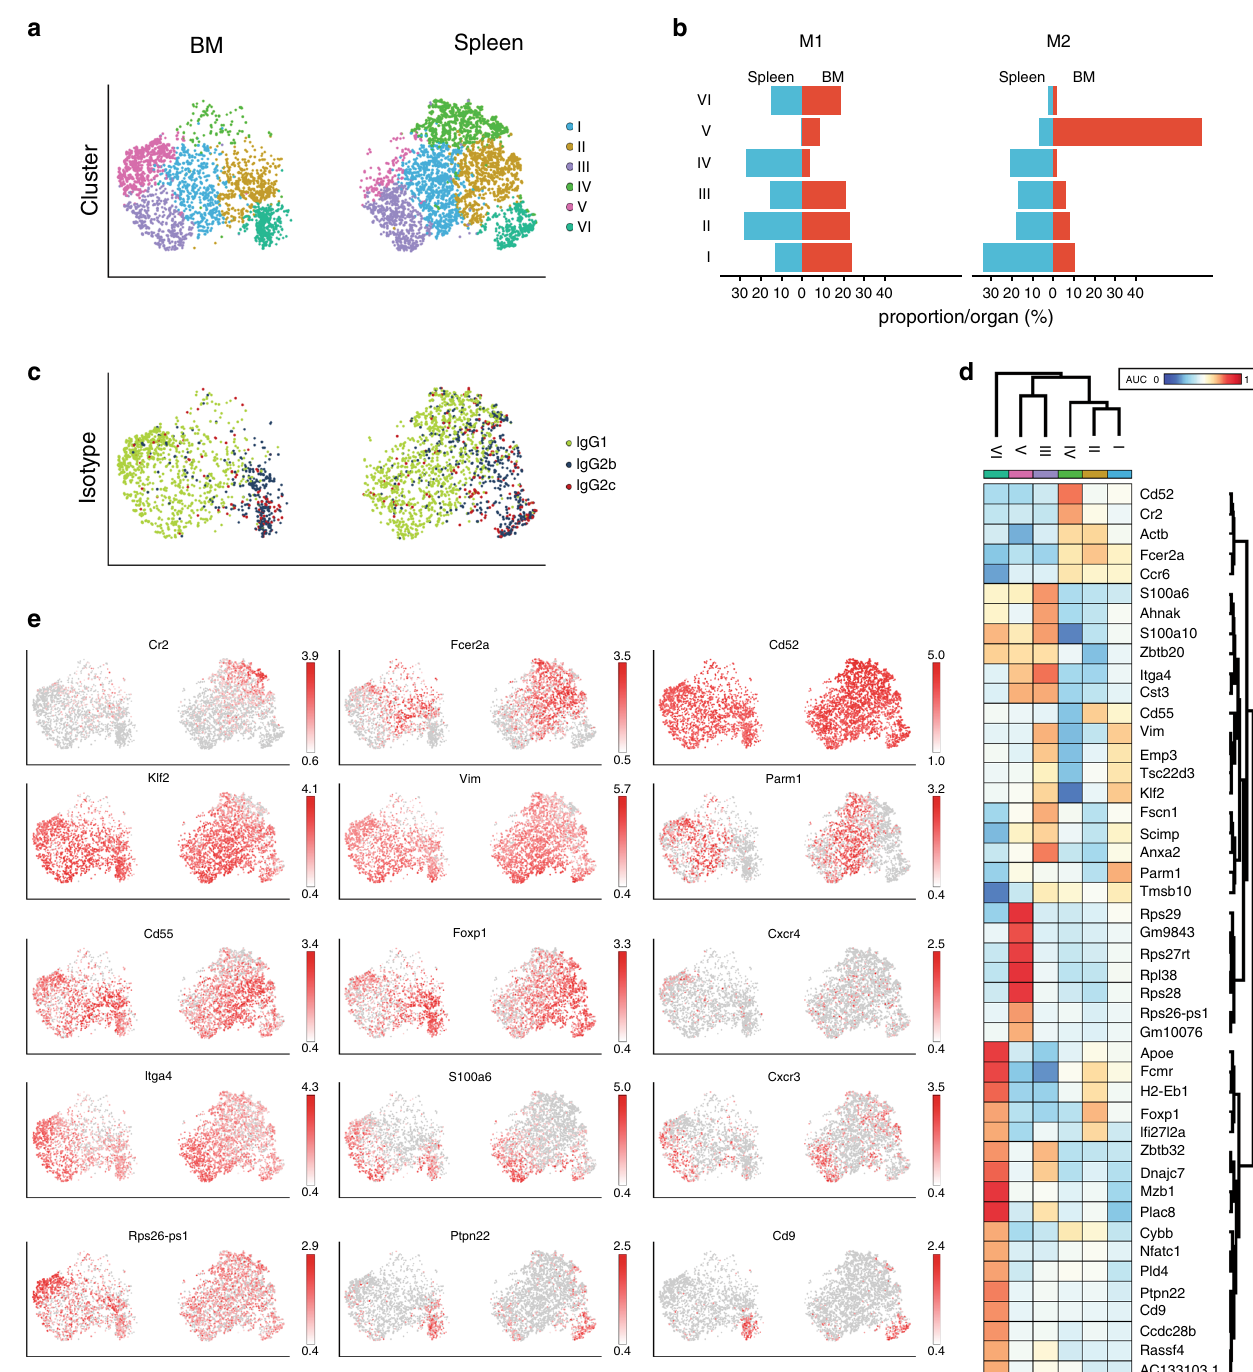
Fig. 3 Heterogeneity of switched memory B cells is differentially represented in spleen and bone marrow. Cells for single cell sequencing were FACSorted as IgG-expressing CD19 + CD38 + CD138 - GL7 − small lymphocytes. a Six transcriptionally de fi ned clusters were identi fi ed by shared nearest neighbor (SNN) modularity optimization based clustering algorithm mapped to tSNE representation of spleen and bone marrow (BM) cells. tSNE coordinates and clustering was computed for 4754 from spleen and 2947 from BM cells, presentation is separated by organ. b Percentage of cells per cluster in each organ by mouse. c Distribution of IgG subclass mapped on tSNE. d Signature genes for each cluster, area under curve (AUC) of receiver- operator characteristics (ROC) of >0.7. e Distribution of transcription levels for representative genes mapped on tSNE. Cells for single cell sequencing